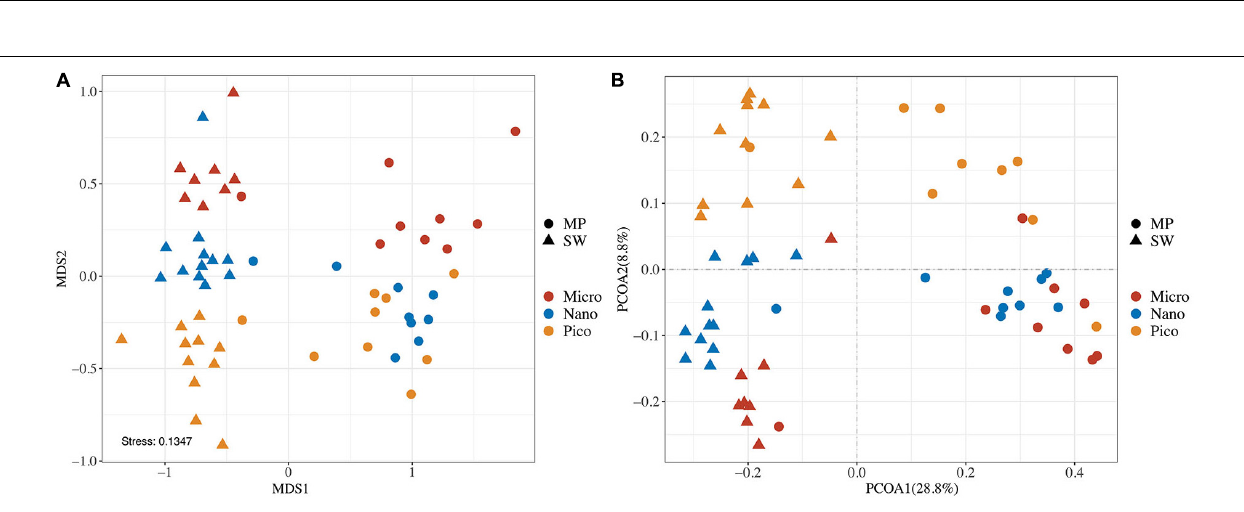
Frontiers in Microbiology |